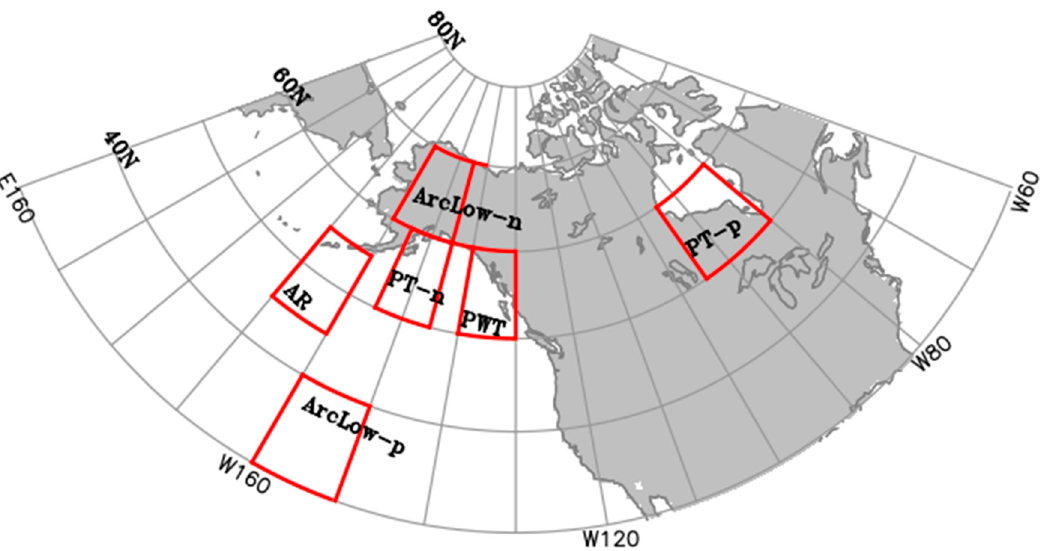
Figure 2. Action centers (outlined by red boxes) at 500 hPa, based on previous studies. Four action centers are chosen in the current study (from left to right): Alaskan Ridge (AR), Pacific High/Arctic Low (ArcLow-n and ArcLow-p), Pacific Trough (PT-n and PT-p), and North American Ridge/Pacific Wave-Train (PWT). In the analysis, ArcLow-n and PT-n were used; –n indicates low-height action centers, and –p indicates high-height action centers.